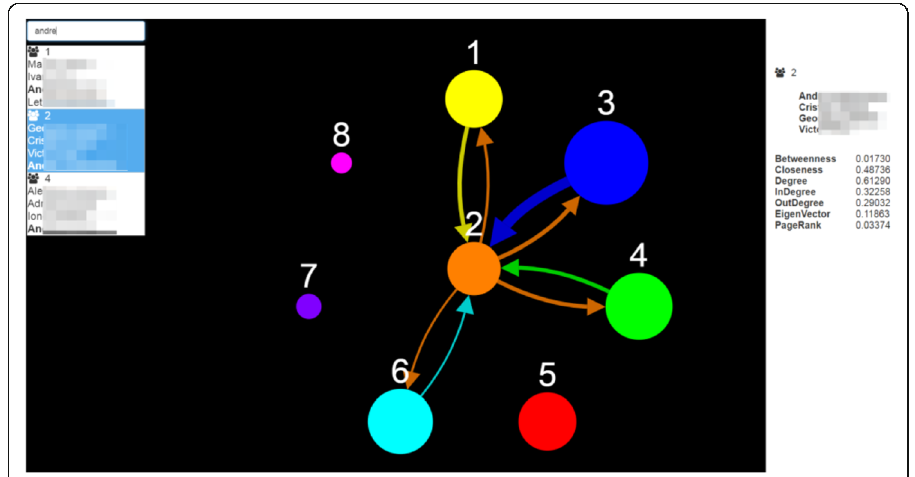
Fig. 5 Visualization provided by StudentViz using Focus-circular layout. Nodes represent teams and their diameters are proportional to PageRank metric. Through this image, an instructor can easily grasp inter- team collaboration status (please note that identifiable information is blurred in the screenshot, in order to preserve students ’ anonymity). This figure supports VN2 as well as